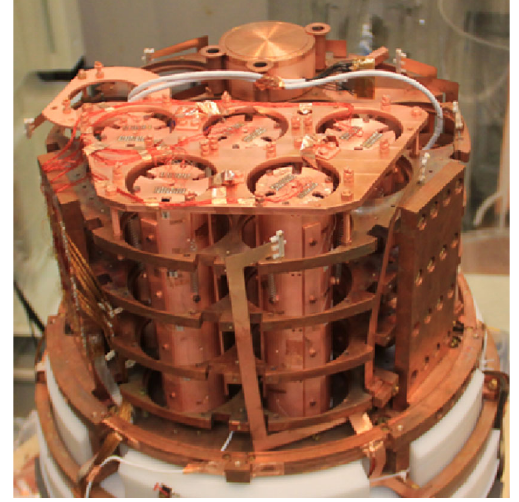
Fig. 7 The CUPID-Mo scintillating bolometer array installed inside the EDELWEISS set-up. The remainder of the experimental volume is occupied by eleven Ge-based bolometers of the EDELWEISS direct dark matter search experiment and one scintillating bolometer for CUPID R&D